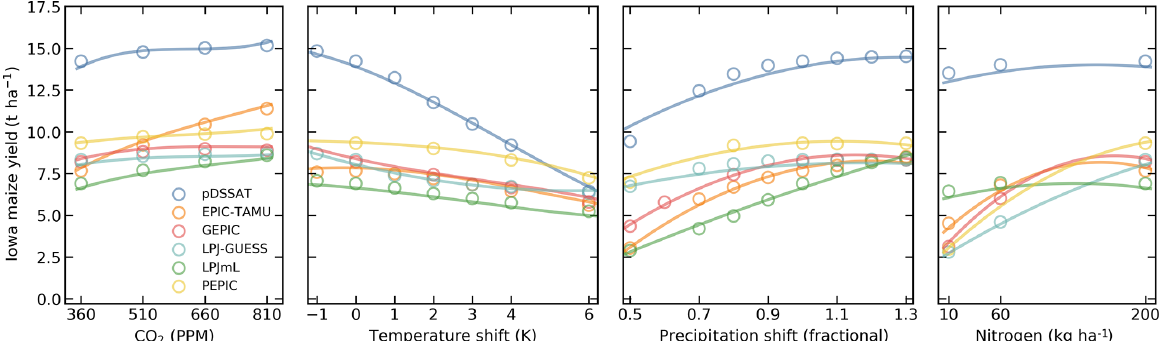
Figure 6. Illustration of variations in yield response across models, again successfully captured by the emulator. Panels show simulations and emulations from six representative GGCMI models for rainfed maize in the same Iowa grid cell shown in Fig. 5, with the same plot conventions. Three models (PROMET, JULES, and CARAIB) that do not simulate the nitrogen dimension are omitted for clarity. Models are uncalibrated, producing spread in absolute yields. While most model responses can readily emulate with a simple polynomial, some response surfaces diverge slightly from the polynomial form, producing emulation error (e.g., pDSSAT here, for water), but resulting error generally remains small relative to differences across